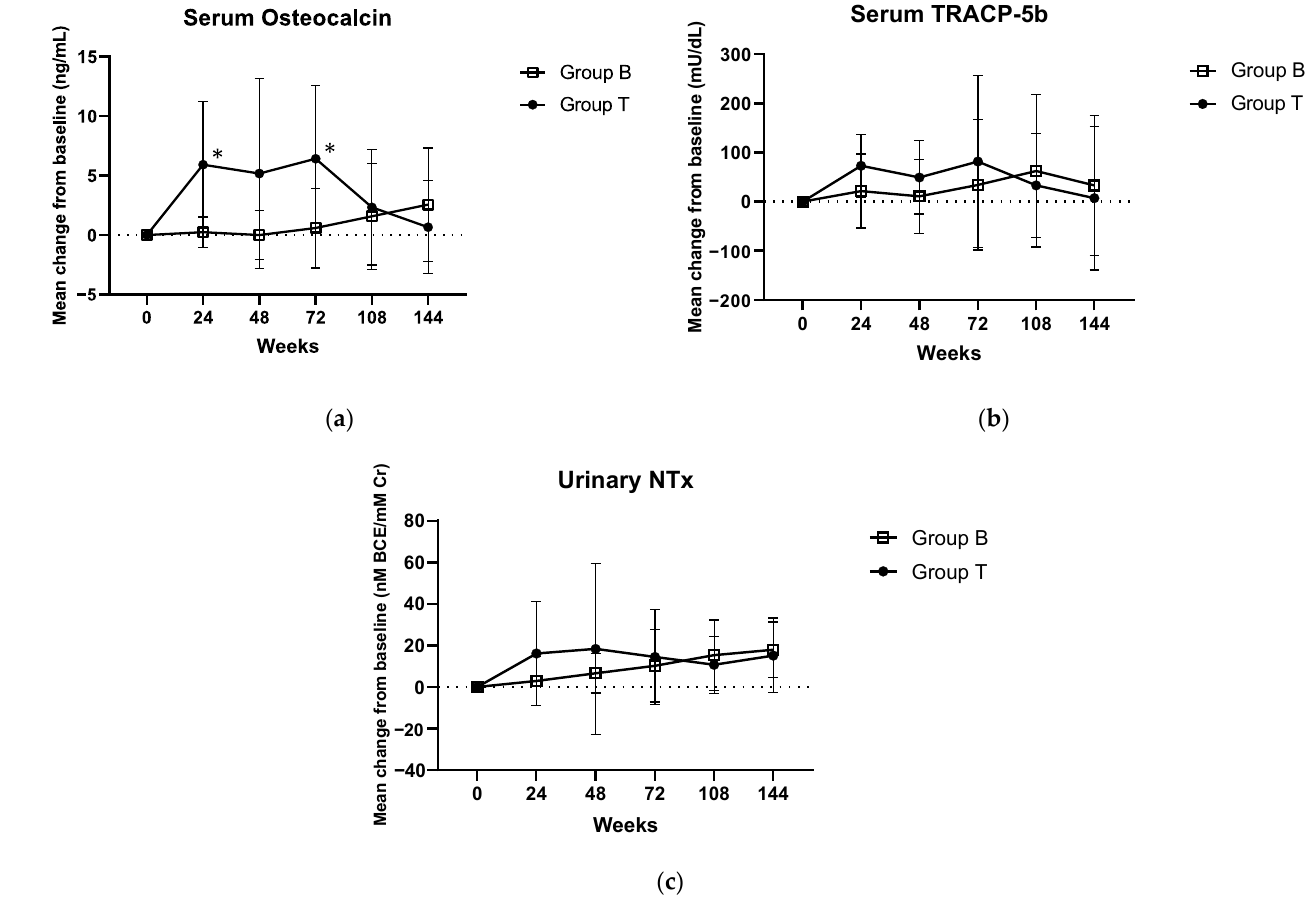
Figure 3. Mean change in ( a ) serum osteocalcin, ( b ) TRACP ‐ 5b, and ( c ) urinary NTx over 144 weeks from baseline for the two treatment groups. TRACP 5b, tartrate ‐ resistant acid phosphatase 5b; NTx, urinary cross ‐ linked N ‐ terminal telopeptide of type I collagen. * p < 0.05, vs. week 0.